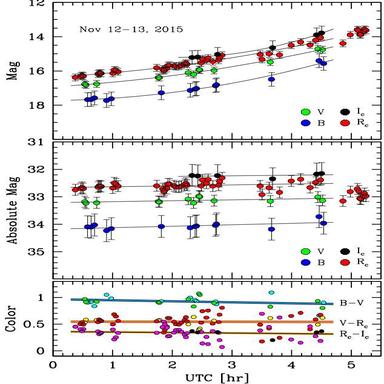
The B; V ; Rc;I c photometry of WT1190F during its final Earth approach of 2015 November 12–13, as seen from Loiano, are reported in the upper panel. Once rescaling for the (quickly reducing) distance, the inferred absolute magnitudes and colors are shown, along the same night, in the mid and lower panels of the figure, respectively. The fit of these data is reported in the set of Eq. (5) relations. Note the abrupt drop in object's R-band absolute luminosity about 05:00 UTC (as in mid panel). The xaxis time